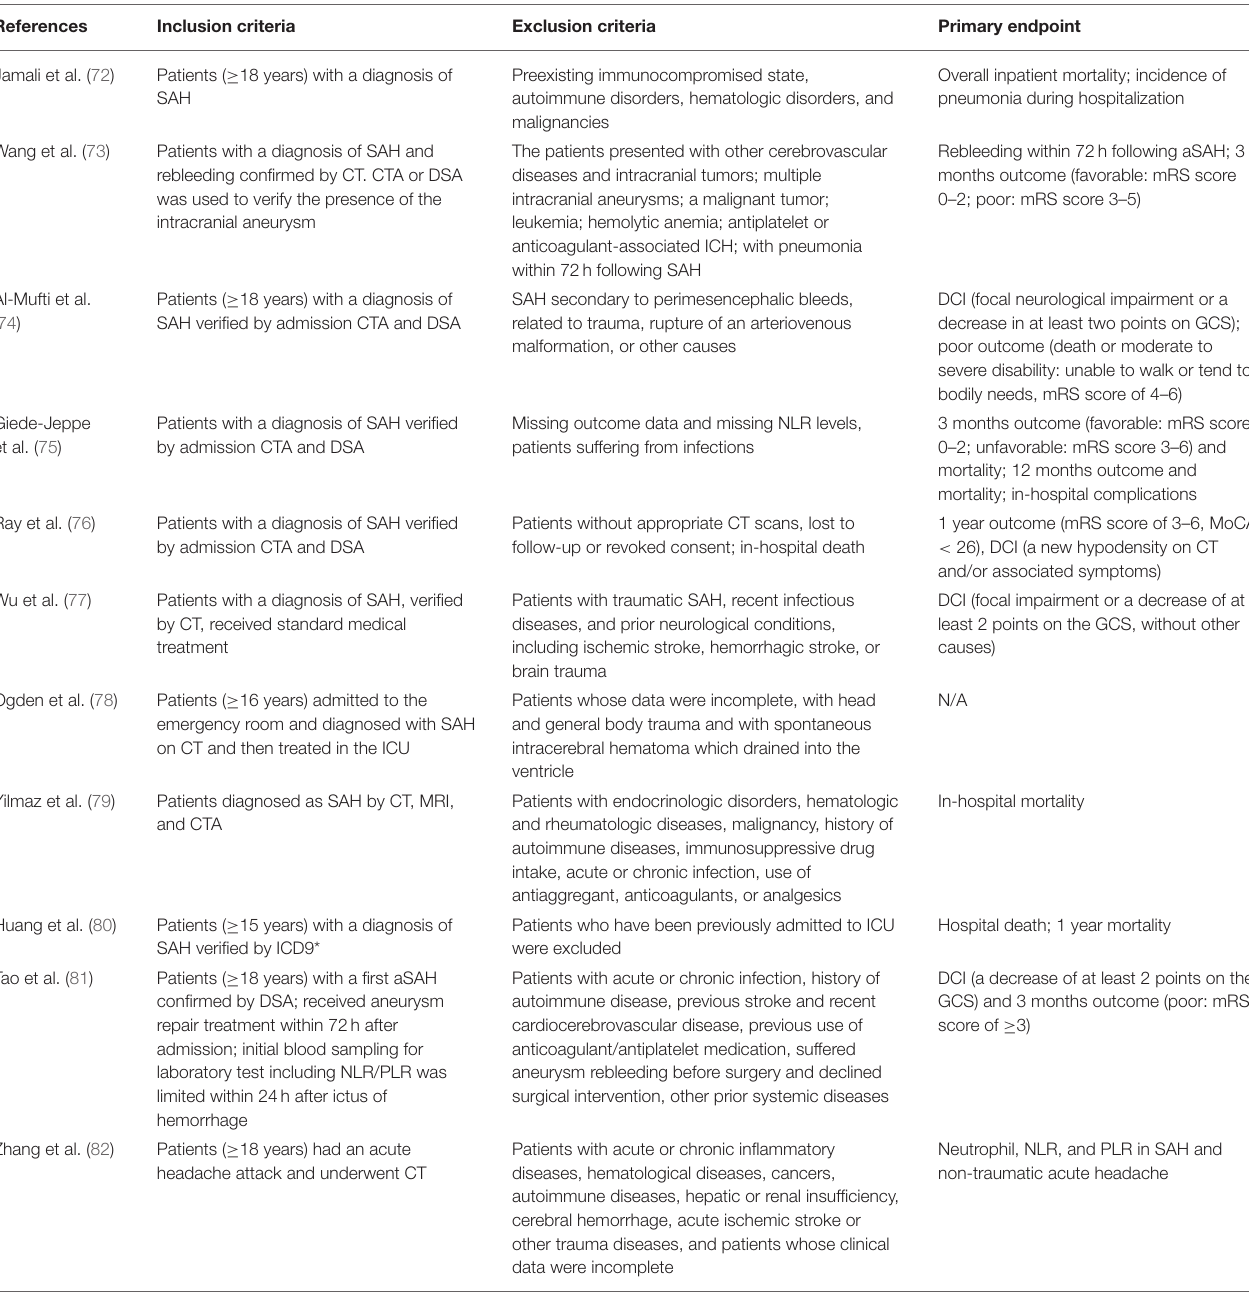
TABLE 1 | Synopsis of the